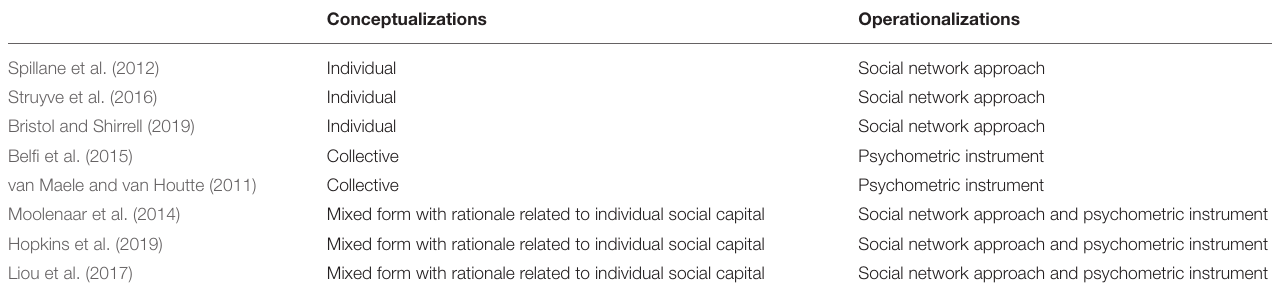
TABLE 2 | Examples of studies using individual, collective, or a mixed form of social